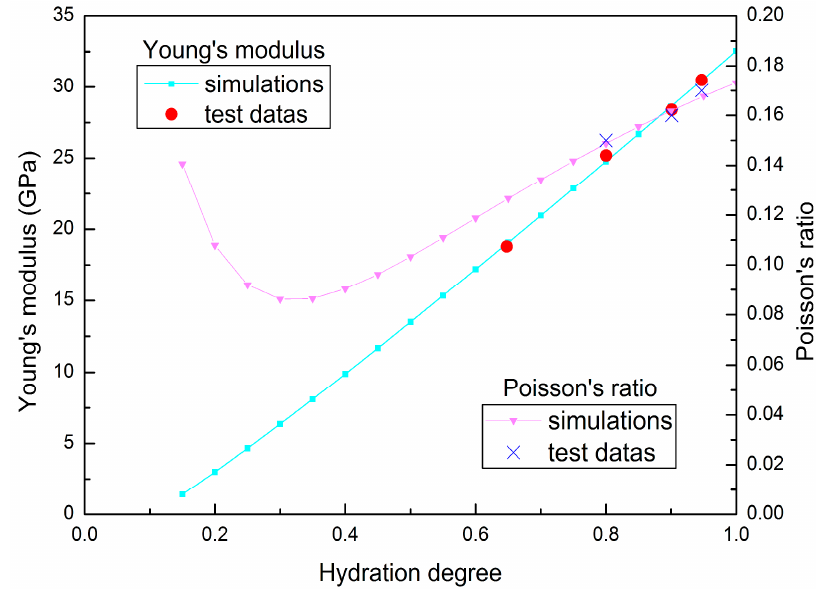
Figure 3. Young’s modulus and Poisson’s ratio evolution for isothermal test of fly ash concrete (w/b = 0.45).